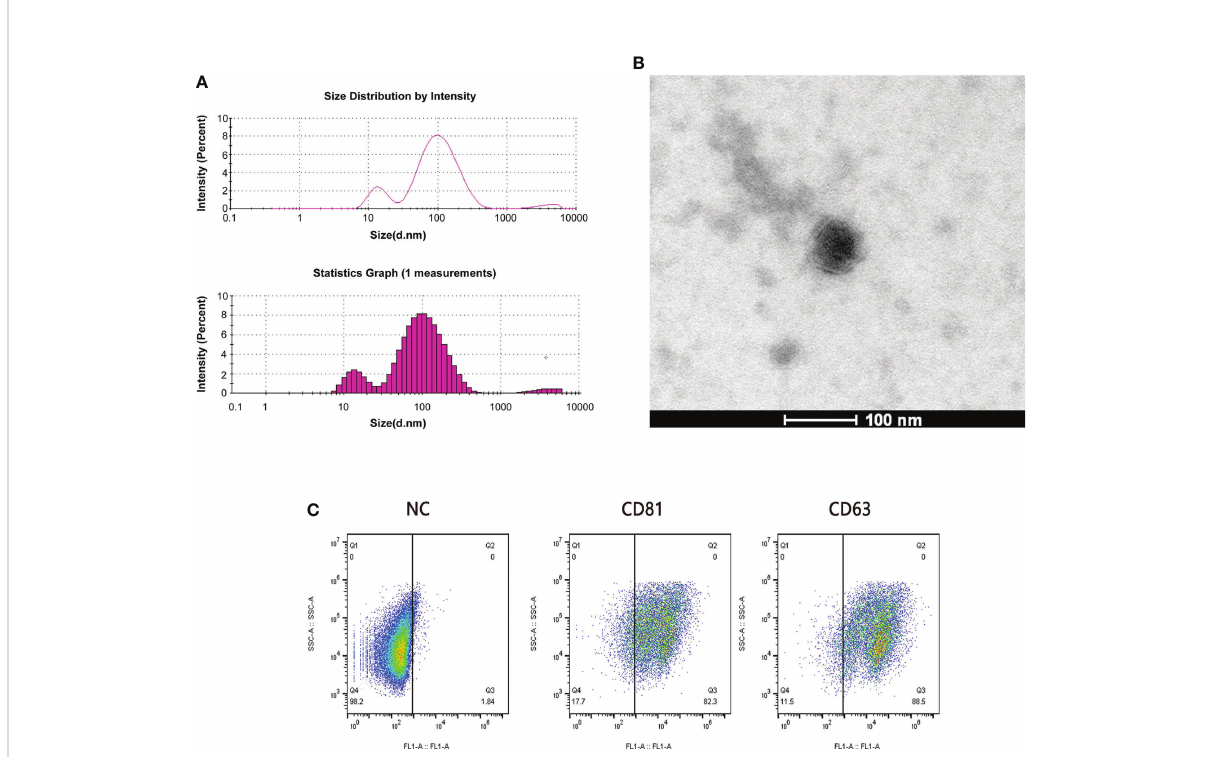
FIGURE 2 Quality examination of plasma exosomes. (A) The average particle size of exosomes was measured by dynamic light scattering (DLS). (B) The form of plasma exosomes was observed by transmission electron microscopy (TEM). Scale bar = 100nm. (C) The purity of plasma exosomes was evaluated through the fl ow cytometry calculating the positive rates of CD81 and